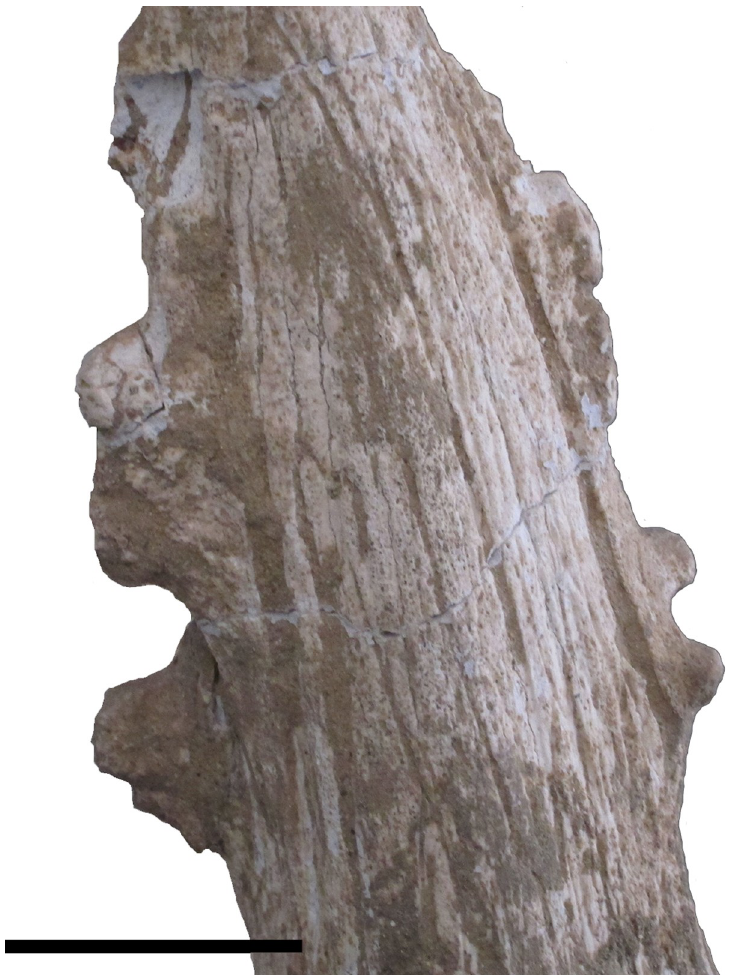
Fig 5. Schansitherium tafeli. (A) HMV 1321. Ossicone detail; right side lateral aspect. Scale